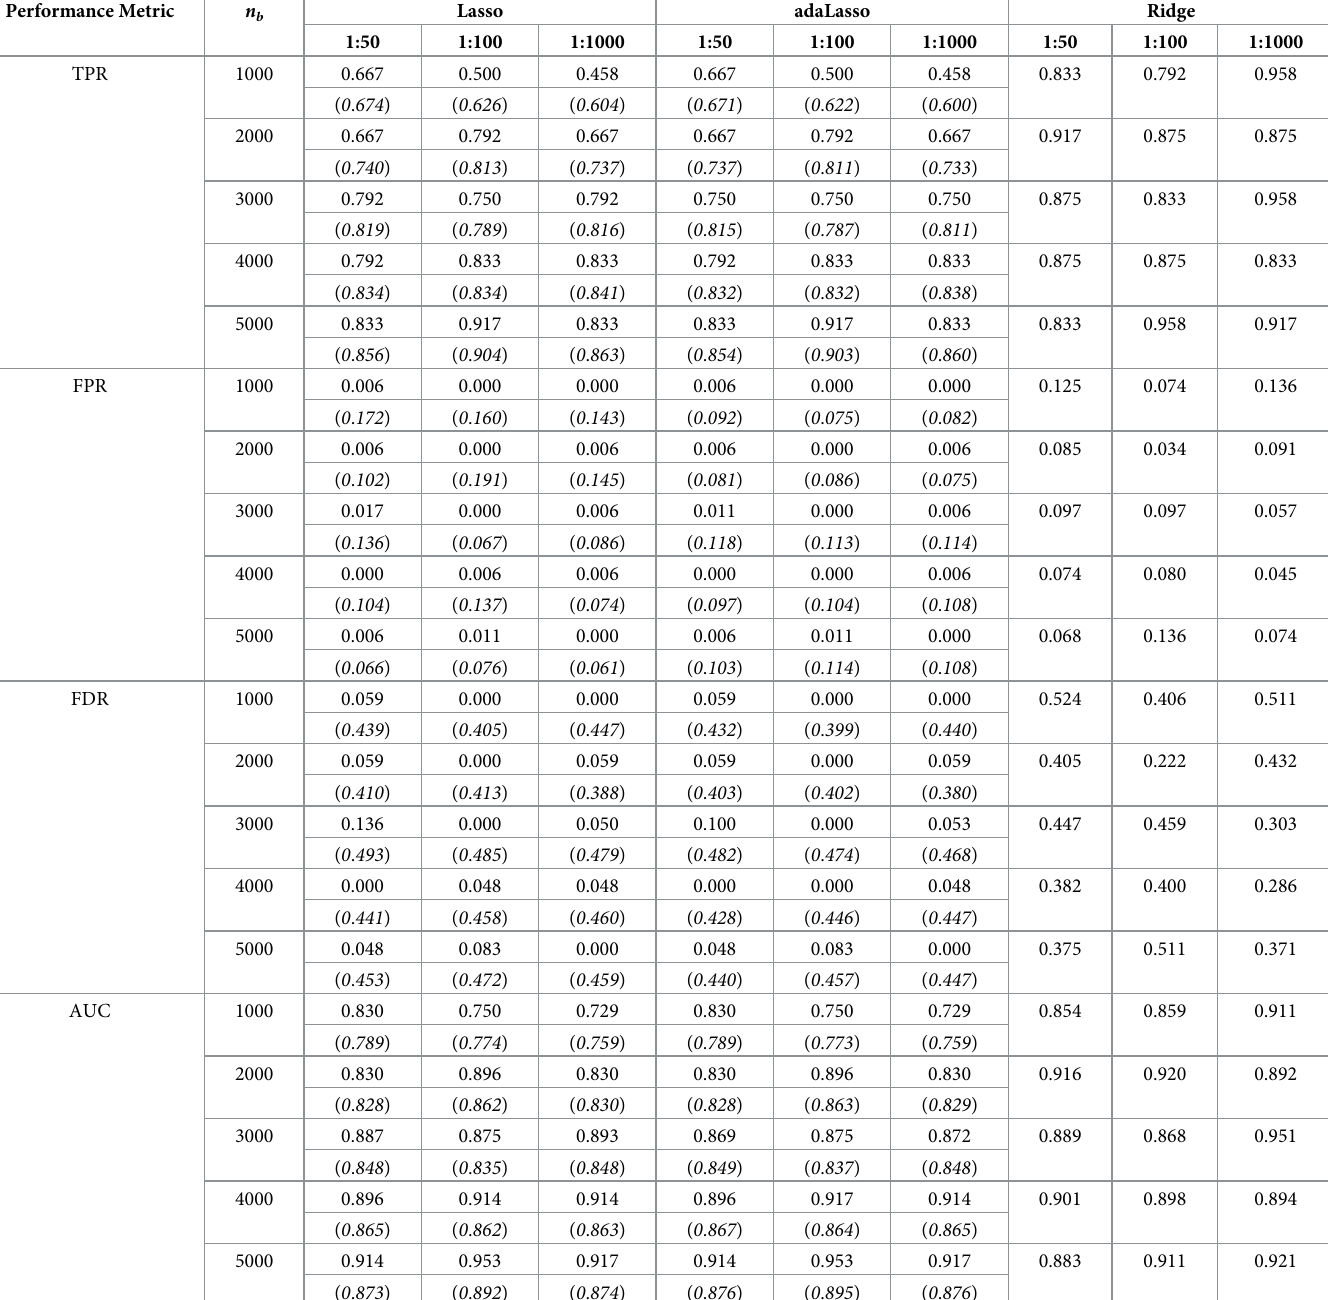
Table 4. Simulation under UNCOR-24. Performance metric scores for variable selection based on the SVRS algorithm and average scores (reported in parenthesis) across 500 individual fits of each regularization model with imbalance ratios 1:50, 1:100 and 1:1000. Performance scores for individual ridge regression fits are not applica- ble as it does not perform automatic variable